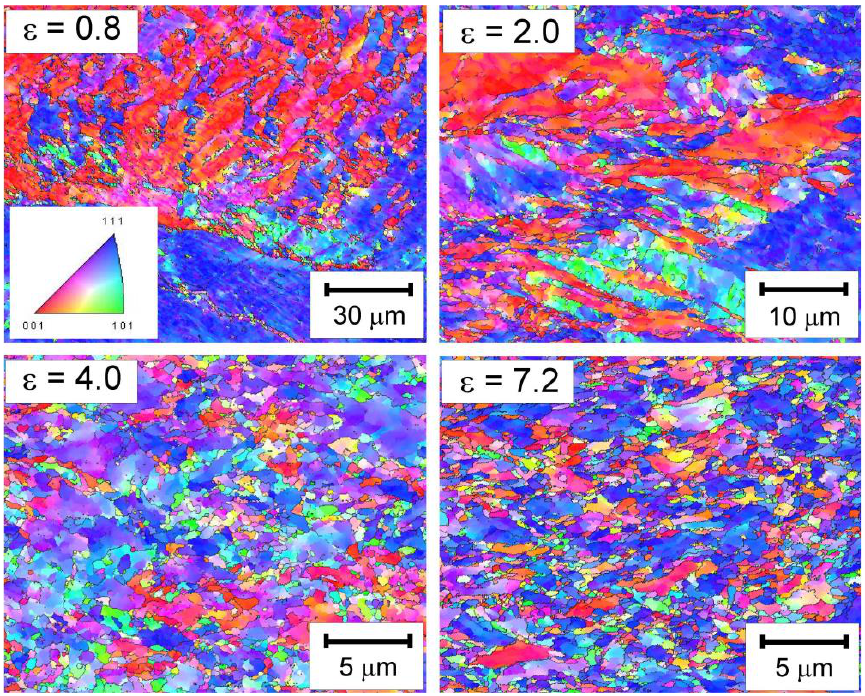
Figure 22. OIM images of a Fe-15%Cr stainless steel processed by multiple forging to the total indicated strains Reproduced from [96] with permission from Elsevier, 2023. Grain boundaries are indicated by black lines. The colors reflect the crystallographic direction along the last-pass forging axis that is vertical in the micrographs.